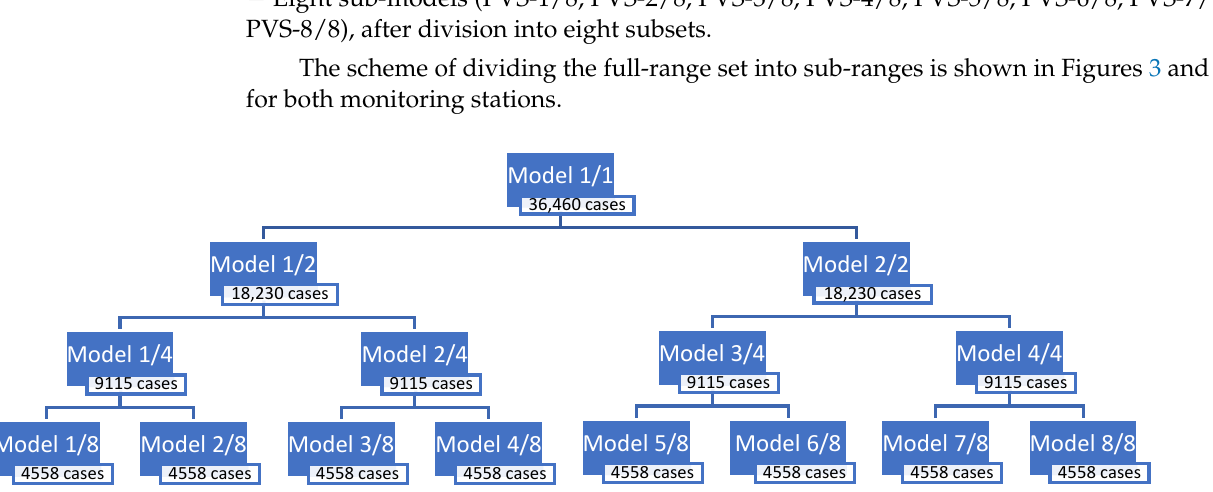
Figure 4. The scheme of the division into sub-ranges for the Z ł oty Potok station. Thanks to the divisions of the full-range set, it was possible to check how the model- ing accuracy changed in the concentration sub-ranges, and whether the modeling carried out in the sub-ranges would improve the modeling quality in relation to the full-range modeling. 2.4. Assessment of the Approximation Error To assess the accuracy of the obtained regression models, the MAE and RMSE values were used, which were calculated on the basis of the discrepancy between the actual and predicted values. The formulas for calculating individual errors are presented in equa- tions 1 and 2. MAE —mean absolute error